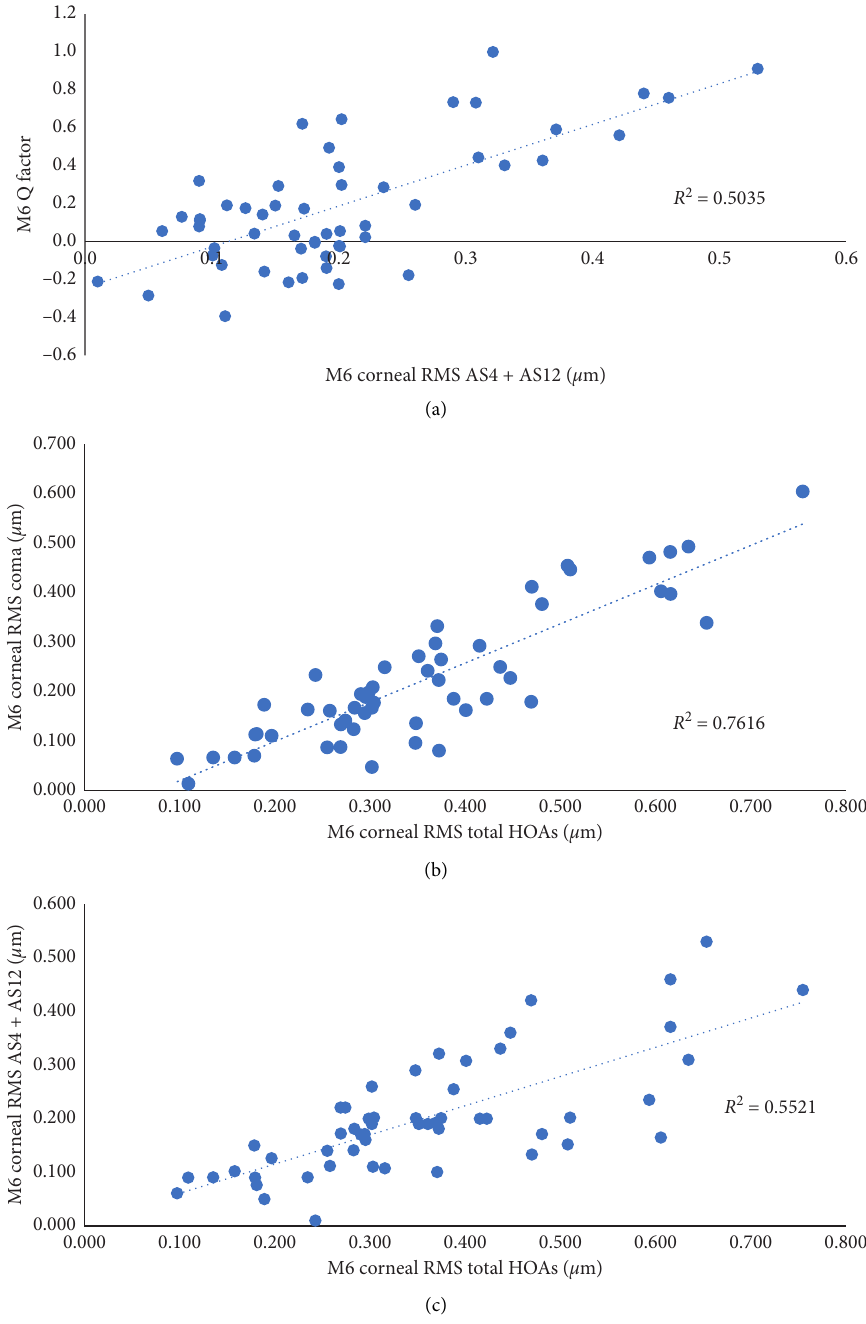
Figure 9: Relationship between spherical corneal aberrations and Q factor (a), between corneal HOAs and corneal coma (b), and between corneal HOAs and corneal spherical aberrations